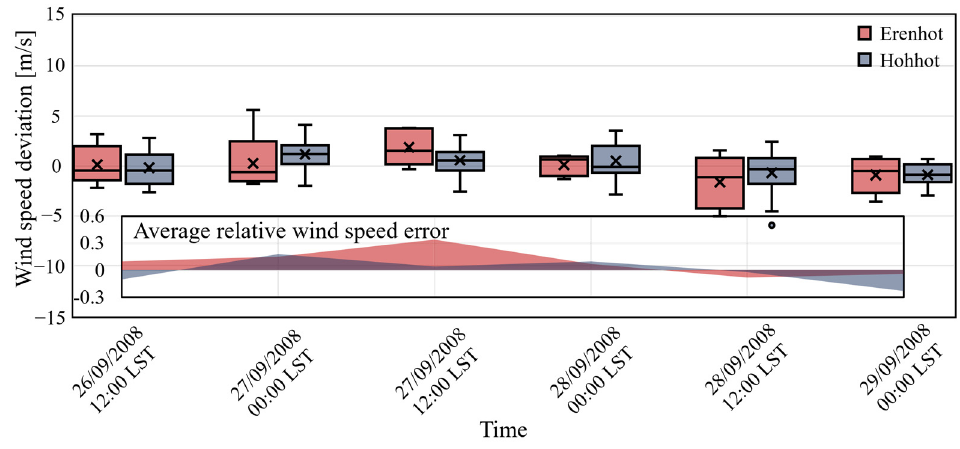
Figure 10. Statistical deviations of mean wind speed field obtained from WRF forecasts in the “Shen Zhou 7” case.